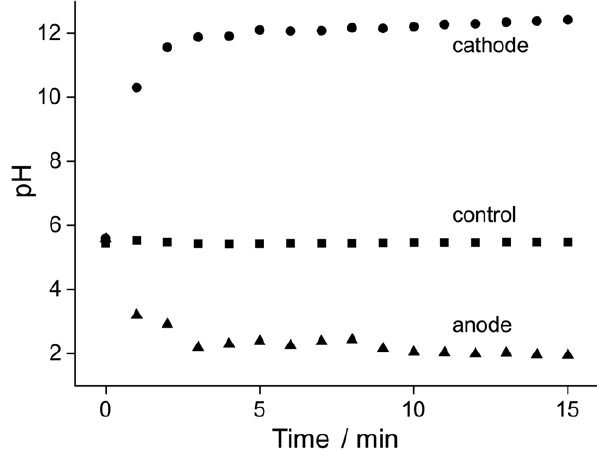
Figure 4. Quantitative pH evolution in the saline around the implant. The evolution of pH in a larger saline environment around the implant measured each minute by a pH microelectrode confirmed the opposing pH drifts at the two implants serving as electrodes.